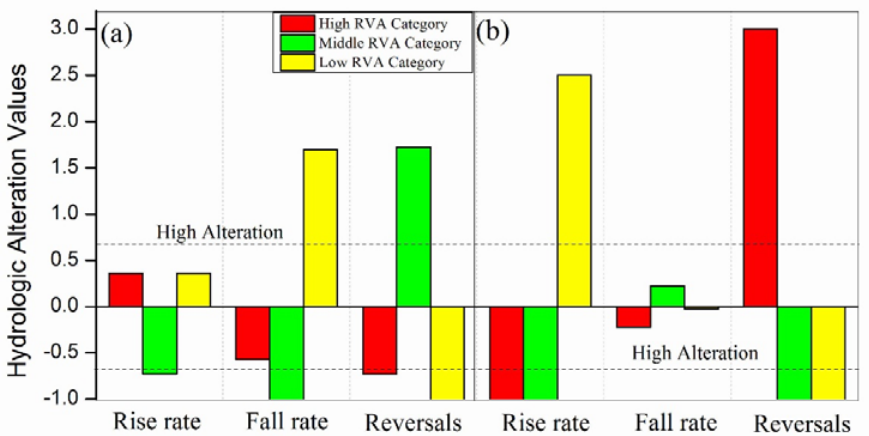
Figure 9. Hydrologic alteration of rate and frequency of the daily streamflow in the JRW based on RVA method. ( a ) North River reach; ( b ) West River reach. Table 6. The change of the rate and frequency of the daily streamflow in the JRW (%). Two Reaches Rise Rate Fall Rate Number of Reversals